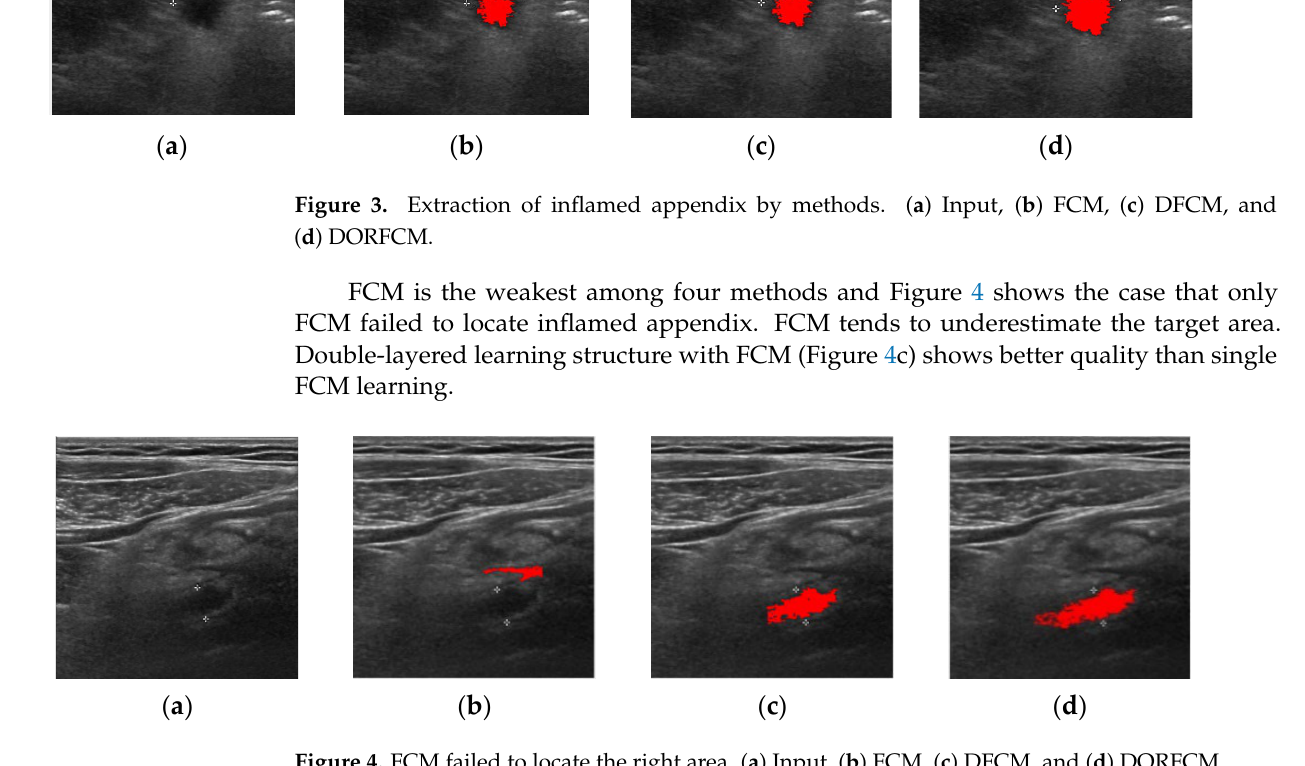
Figure 4. FCM failed to locate the right area. ( a ) Input, ( b ) FCM, ( c ) DFCM, and ( d ) DORFCM. DFCM showed better performance than FCM to avoid local maximum in clustering.